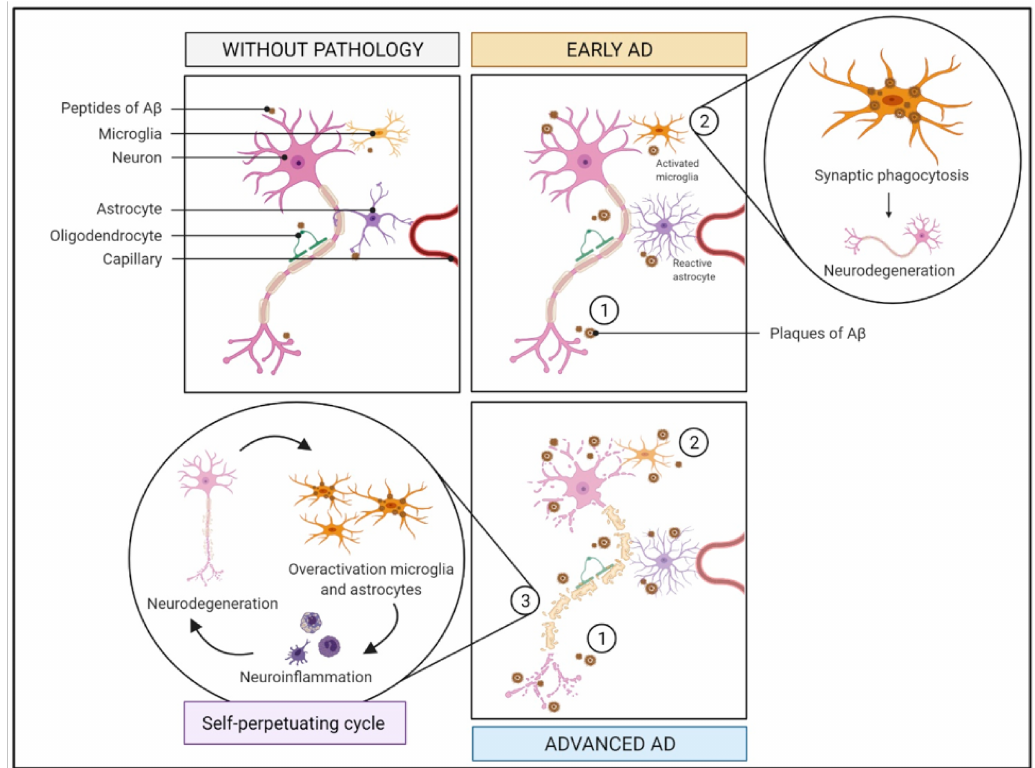
Figure 2. Immune system and inflammation pathway in AD. In AD, the accumulation of A β plaques (step 1) causes activa- tion of microglia resulting in synaptic phagocytosis (step 2) and therefore neurodegeneration. This creates a self-perpetuating cycle (step 3) that increases neurodegeneration and induces a state of chronic neuroinflammation. Abbreviations: A β , amyloid beta; AD, Alzheimer’s